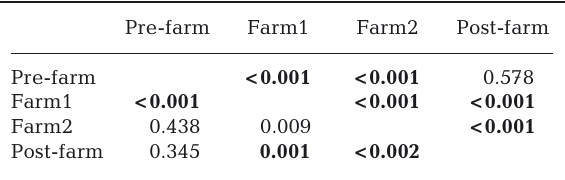
Table 4. p-values from pairwise exact G-tests of genic differ- entiation across all loci and Atlantic cod samples (Fisher’s method). Significant p-values after Bonferroni correction are shown in bold (adjusted p-value = 0.009). Above